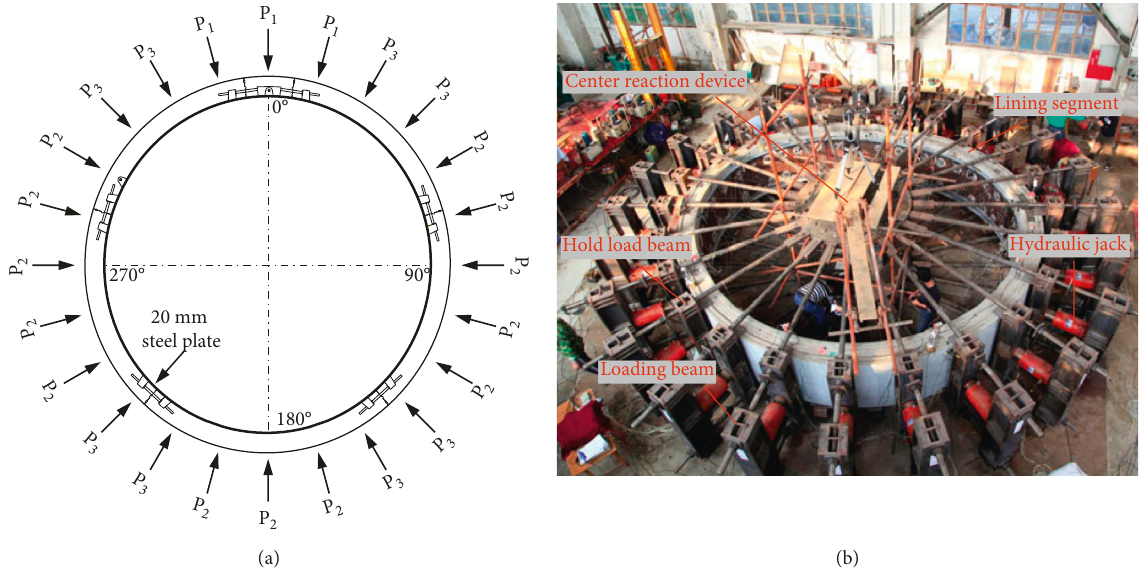
Figure 6: Full-scale experiment [5]. (a) Load distribution. (b) Top view of the